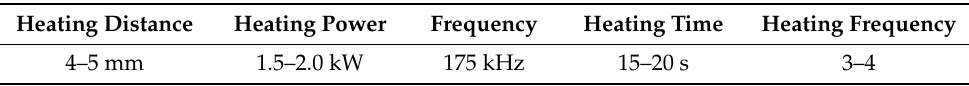
Table 2. Processing parameters of the induction remelting.